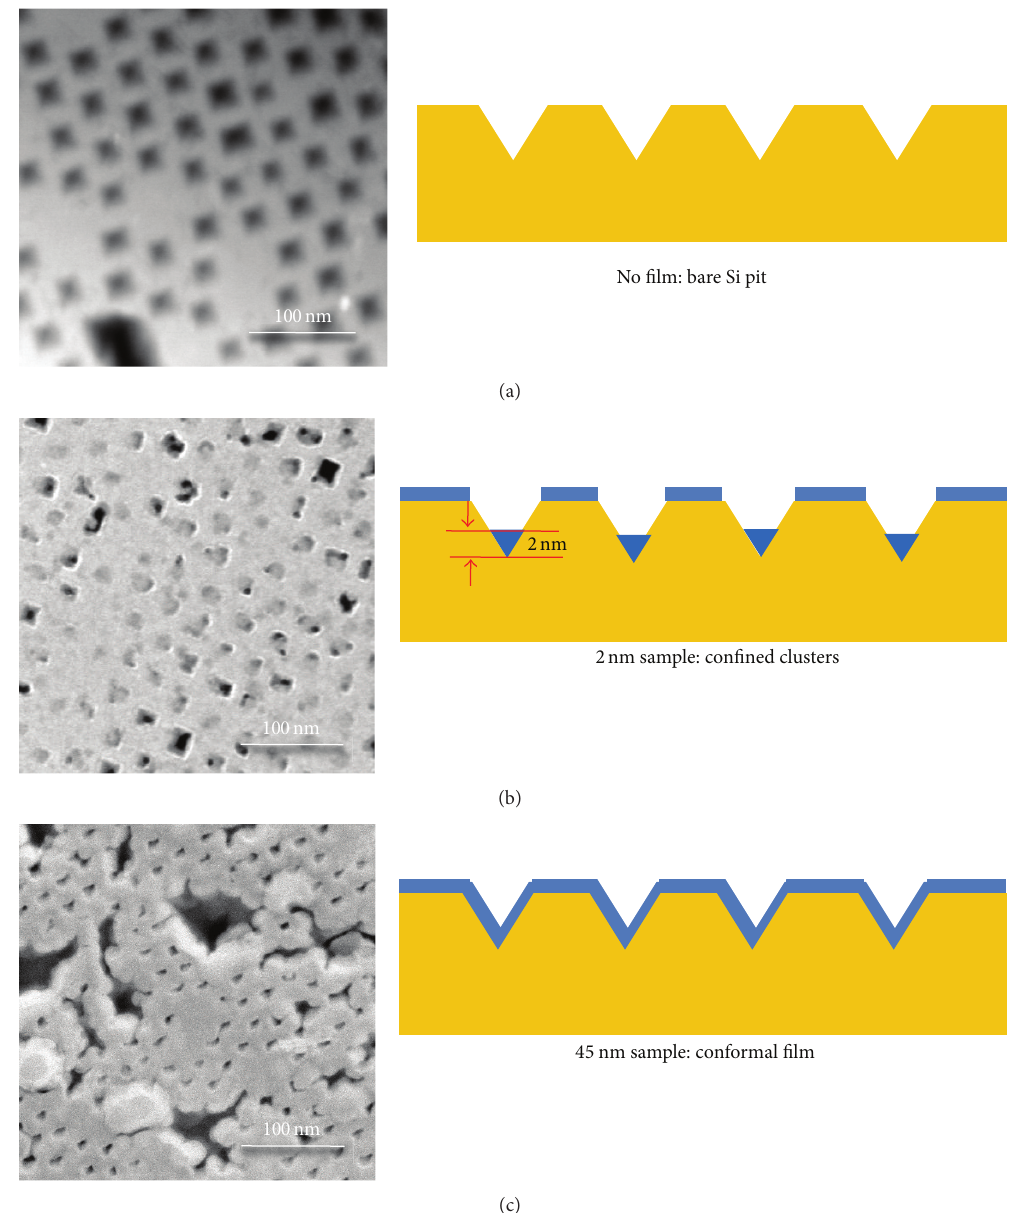
Figure 2: STEM images of (a) bare nanopit Si substrate and (b) 2 nm and (c) 45 nm In 2 Se 3 deposited on Si nanopit substrate with cross section schematic of film